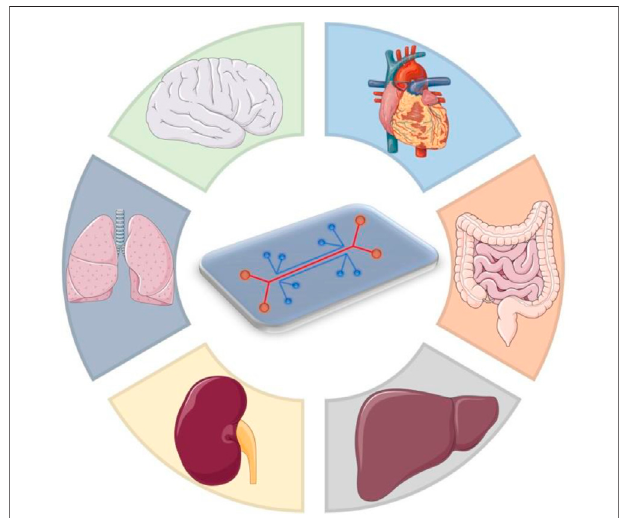
FIGURE 1 | Multi-organ chip platform for disease